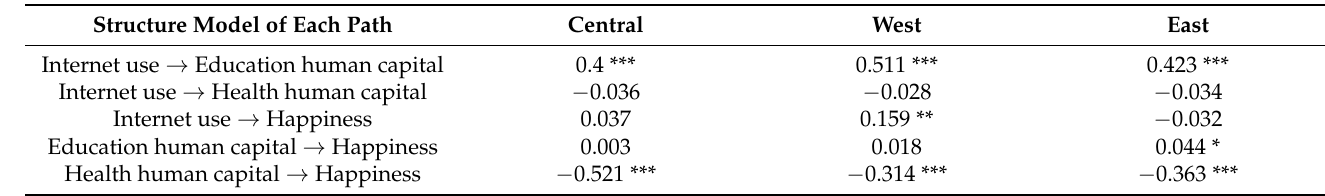
Table 5. Heterogeneity analysis by